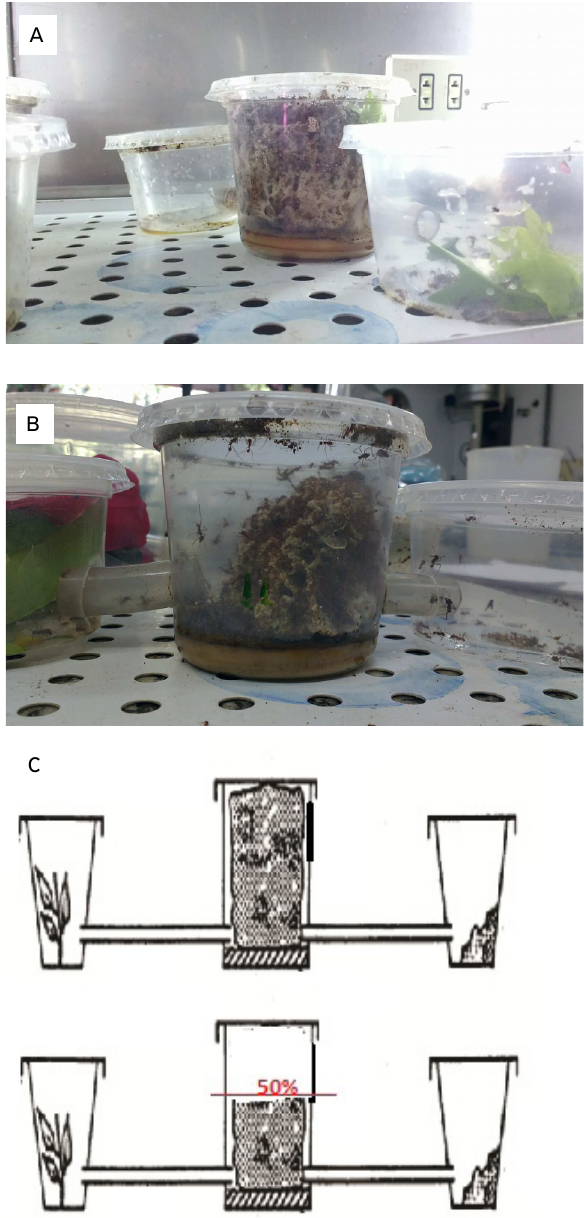
Figure 1. Mini colony: before (A) and after (B) one week exposure to 1 mL of tryptic soy broth (TSB) cultivation medium with bacteria. (C) Representation by Forti et